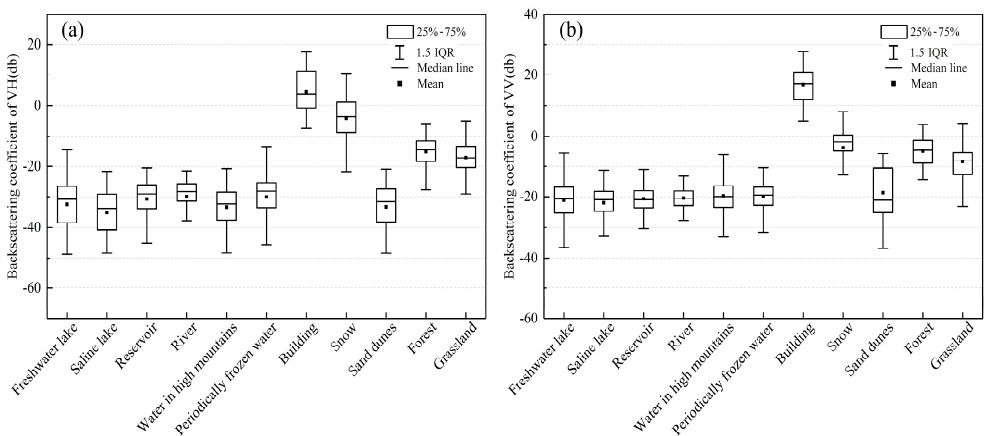
Figure 3. The backscatter coefficients of 11 land-cover types on ( a ) VH polarized images and ( b ) VV polarized images.